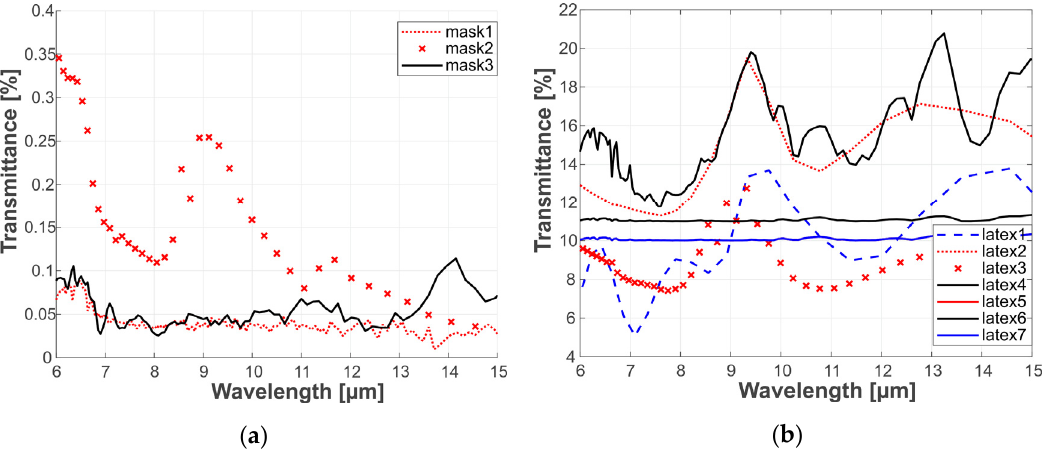
Figure 3. Thermal transmission characteristics of ( a ) 3D- printed masks and ( b ) full-face latex masks in the range of 6–15 mm.